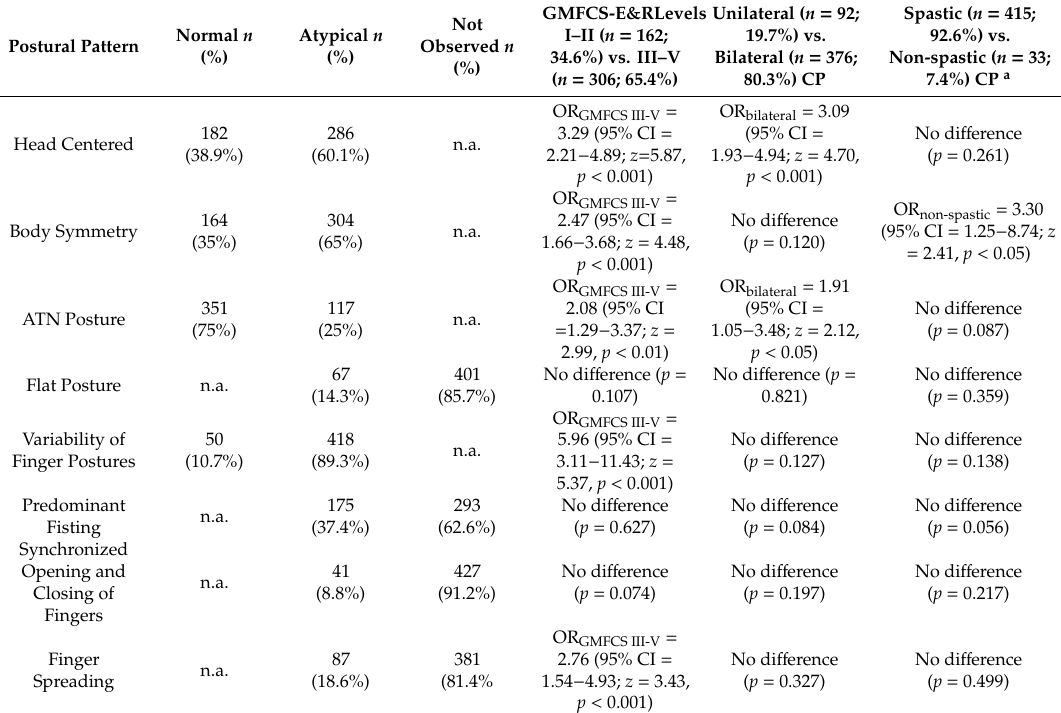
Table 5. Postural patterns at 3–5 months and their normal vs. atypical occurrence in 468 infants later diagnosed with cerebral palsy